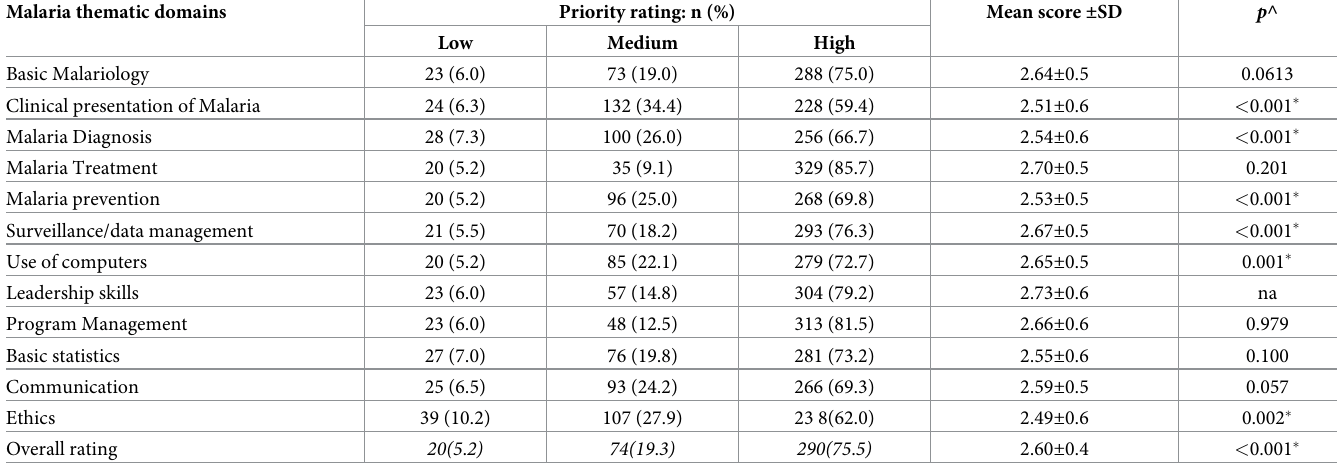
Table 3. Distribution of respondents’ priority rating and differences in mean scores of topics by thematic